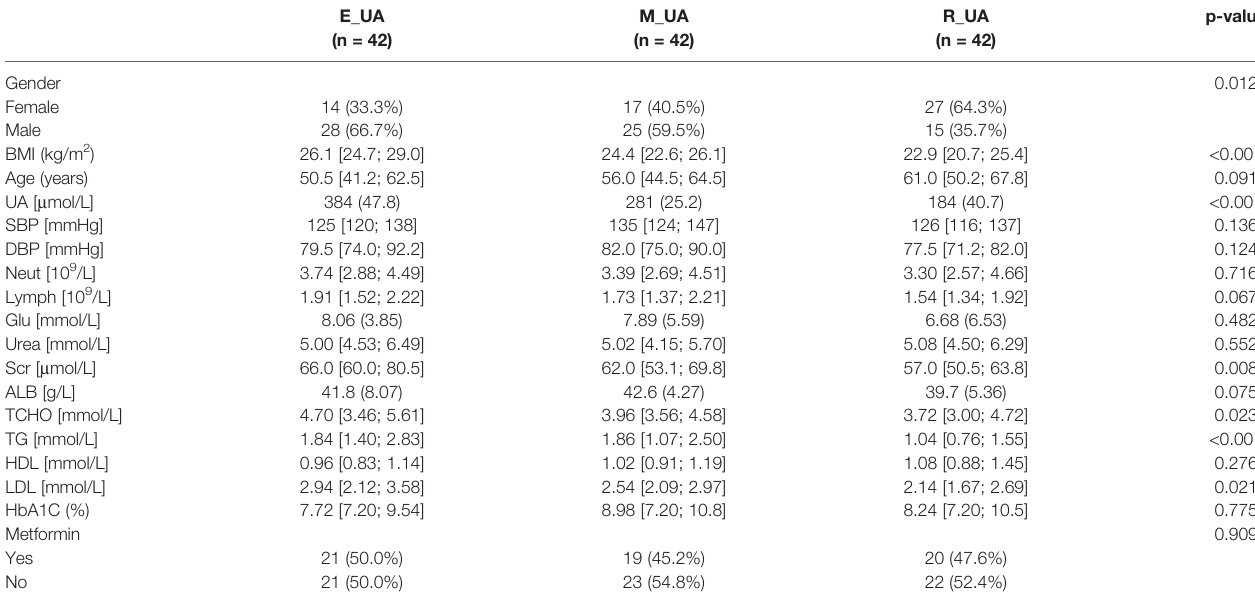
TABLE 1 | Characteristics of the subjects according to sUA